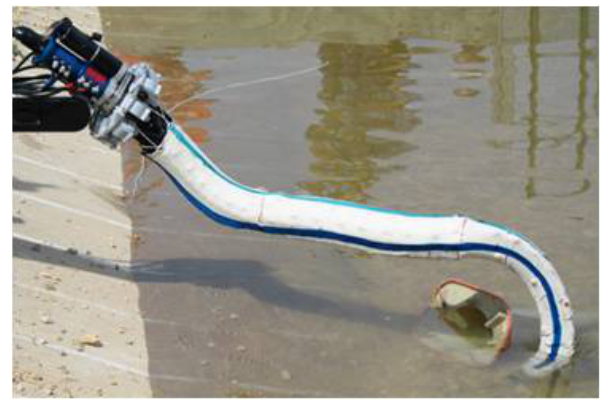
Figure 1. Octarm Continuum Robot